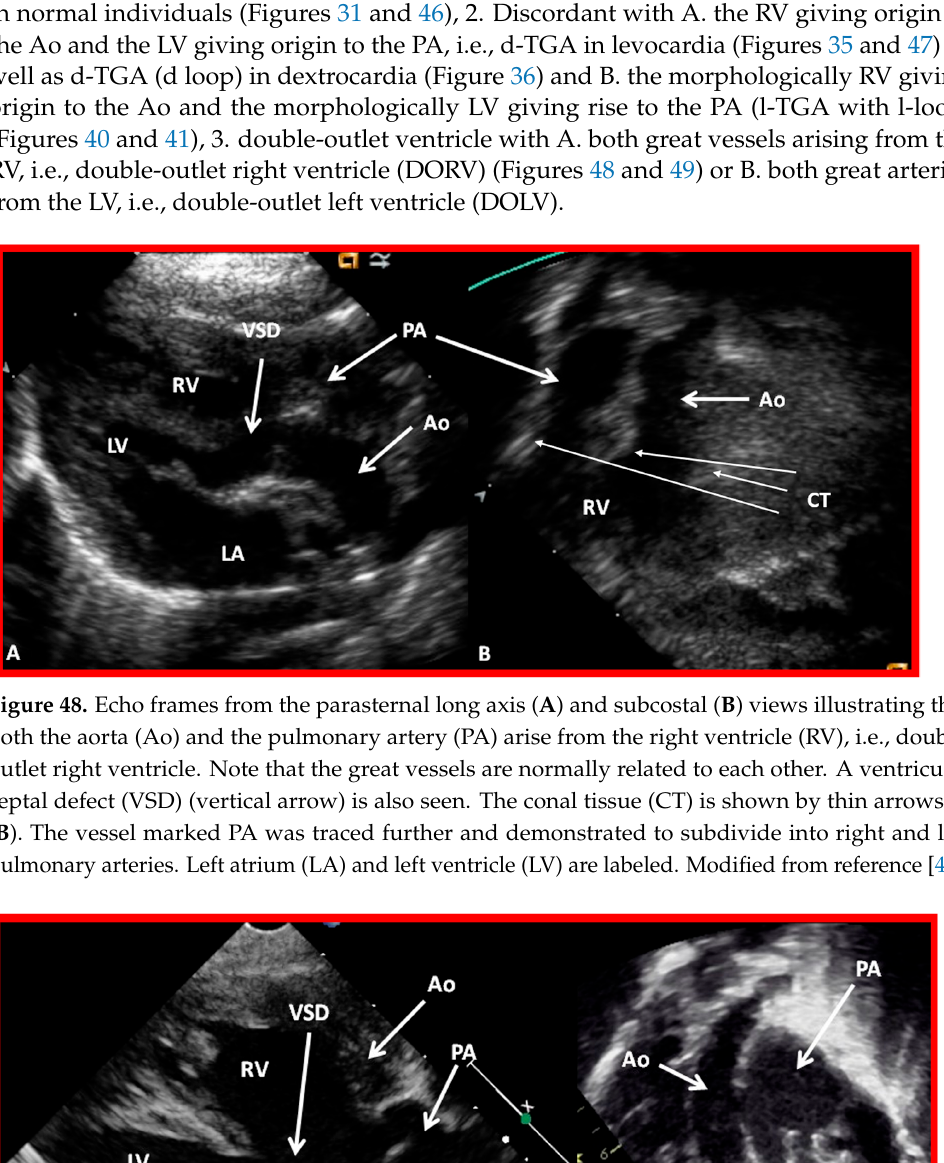
Figure 47. Echo images in parasternal long ( A ) and short ( B ) axis projections of a baby with trans- position of the great vessels illustrating anterior ( A , B ) and right-ward ( B ) position of the aortic valve and aorta (Ao) relative to the position of the pulmonary valve and pulmonary artery (PA). These images also demonstrate that the PA and Ao are in parallel position ( A ). Left atrium (LA), left ven- tricle (LV), right atrium (RA), and right ventricle (RV) are labeled. Replicated from reference [42].